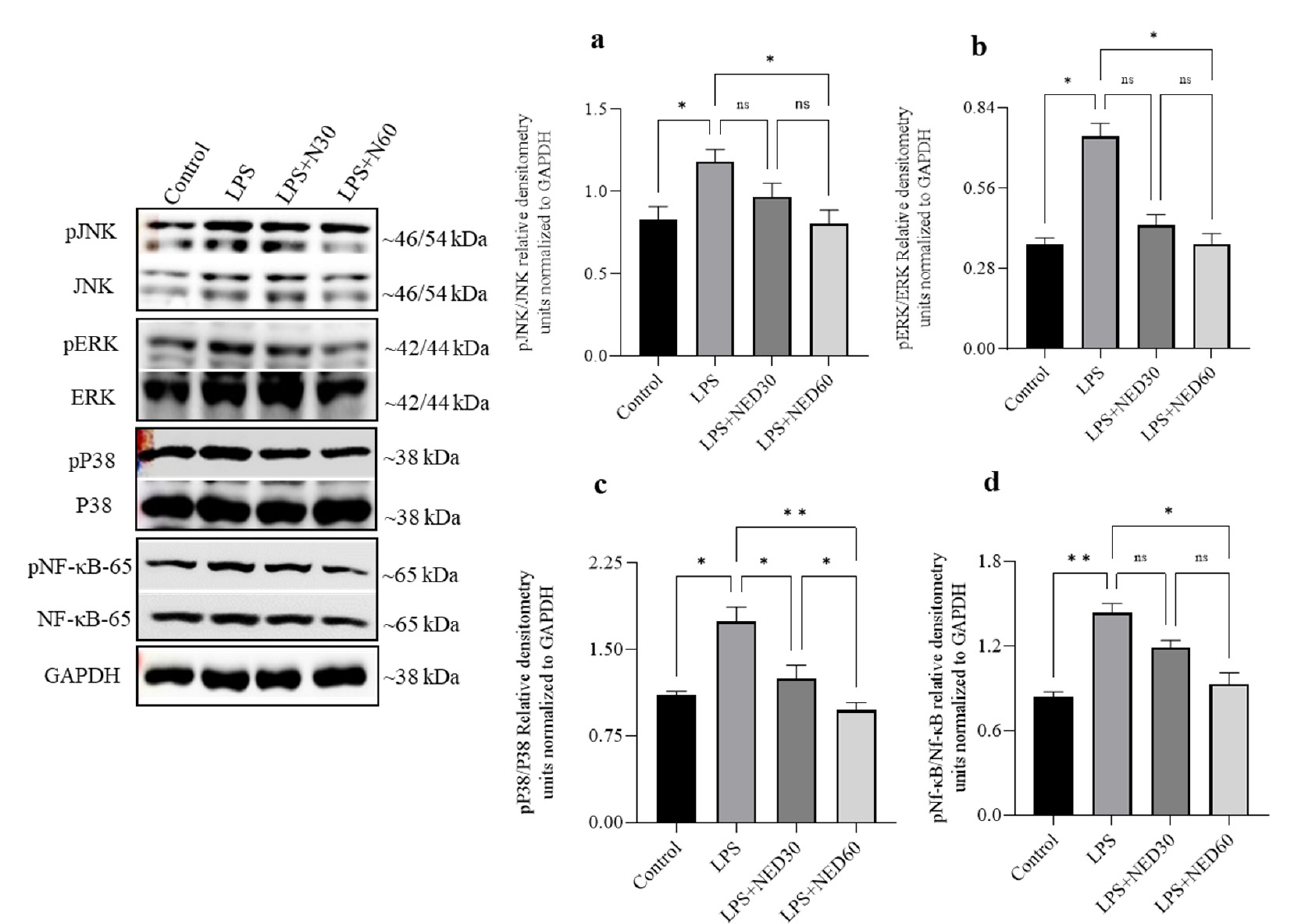
Figure 3. Effect of NED pre-treatment on the phosphorylation of MAPK and NF- κ B proteins in LPS-stimulated RAW Macrophages. NED treatment significantly prevented the phosphorylation and activation of p38, JNK, and ERK1/2 MAP kinases and NF- κ B induced by LPS in RAW macrophages ( a – d ). Densitometry values are expressed as means ± SEM (n = 4). ** p ≤ 0.01, * p ≤ 0.05, and ns indicates not signi fi cant.